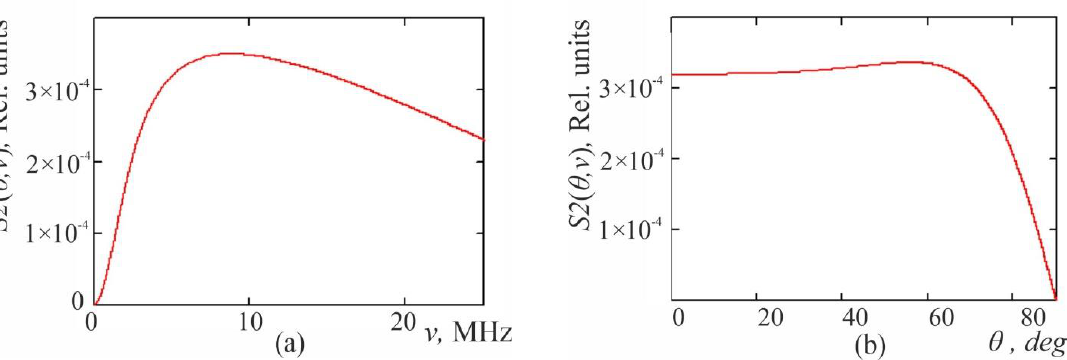
Figure 4. ( a ). Function S 2( θ , ν ) versus frequency ν at θ = 10 ◦ . Sphere diameter is 200 µ m. ( b ) Function S 2( θ , ν ) versus angle θ at frequency ν = 5 MHz. Sphere diameter is 200 µ m.